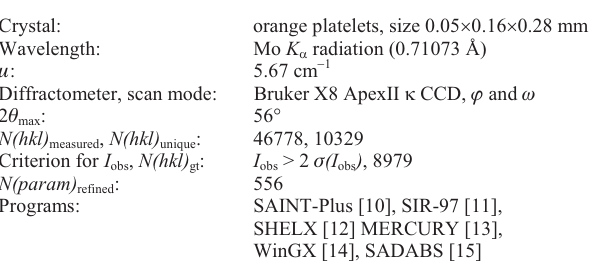
Table 1. Data collection and